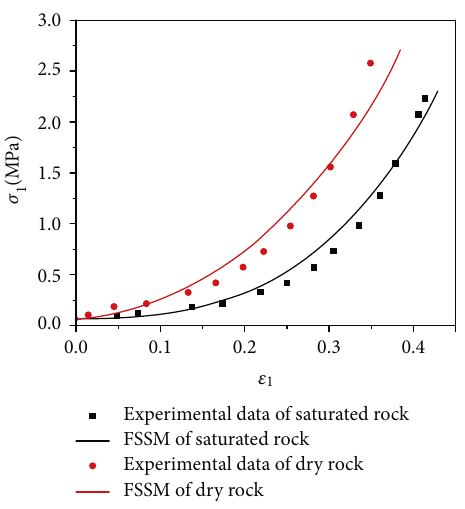
Figure 6: Stress-strain curves of the water storage media.